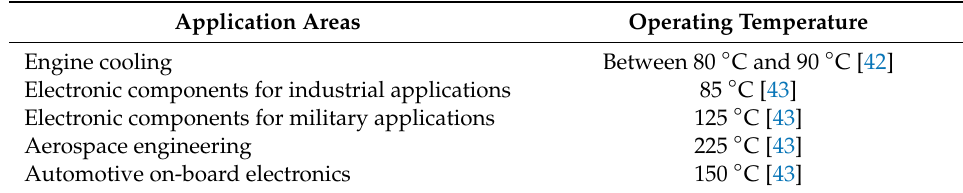
Table 3. Operation temperature in diverse application